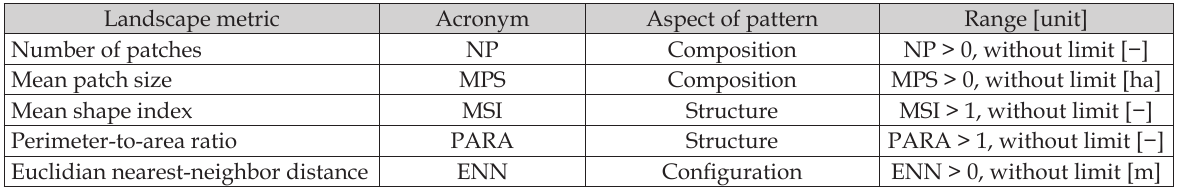
Table 2. Description of landscape metrics used in this research, adapted from Leitão et al. (2012).